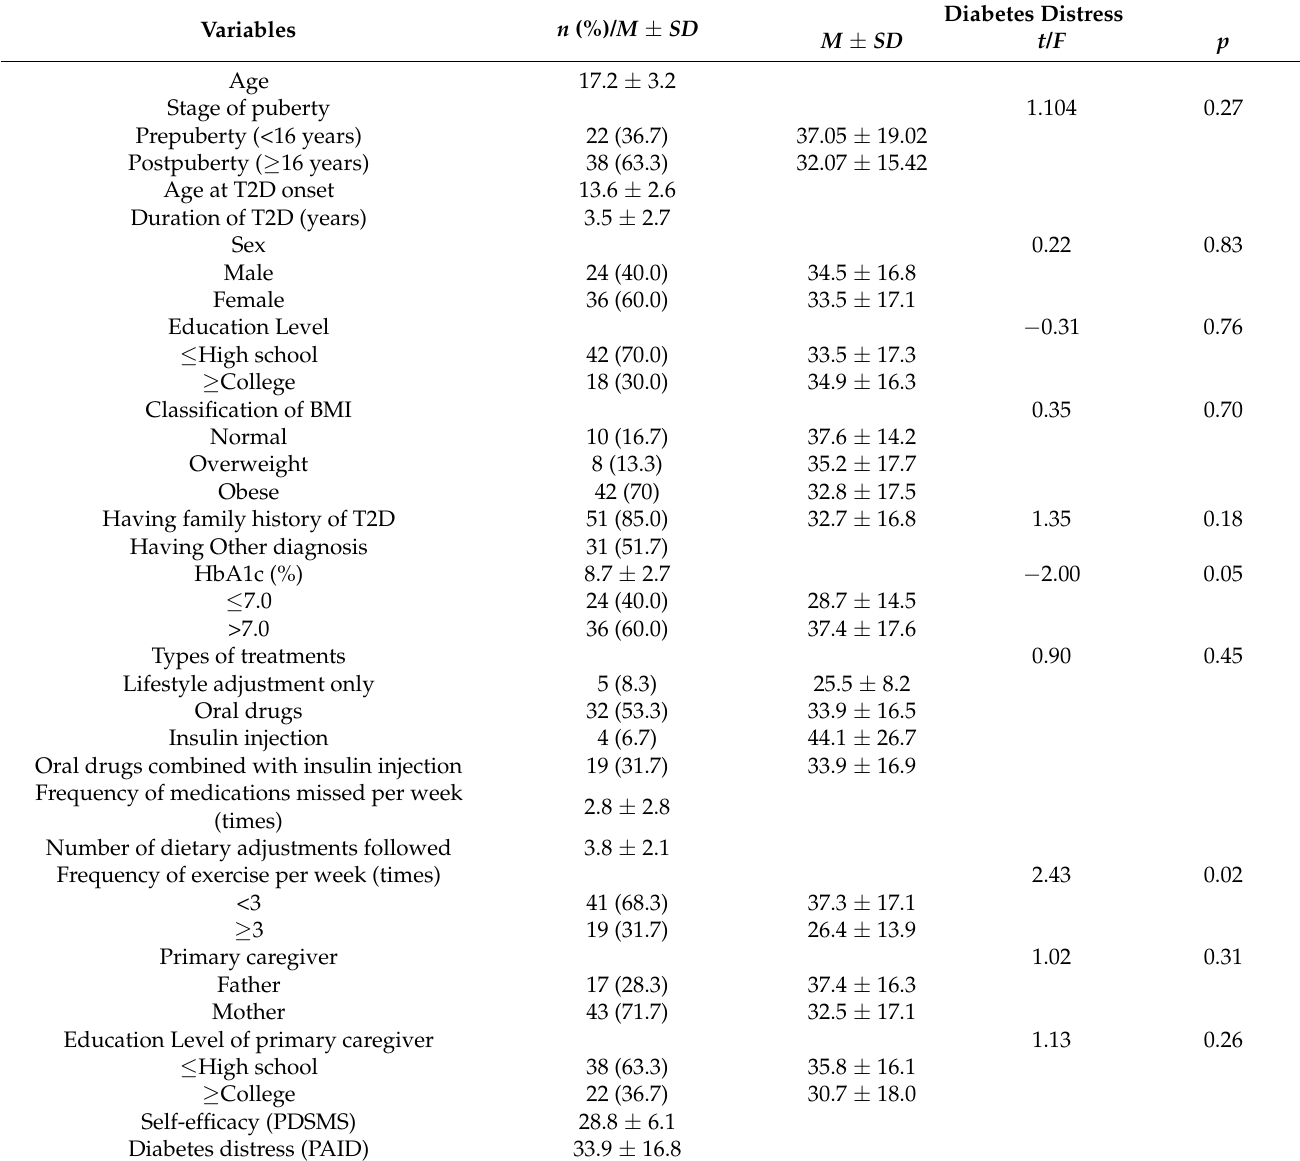
Table 1. Characteristics of participants, study variables and their association with diabetic distress (N = 60).